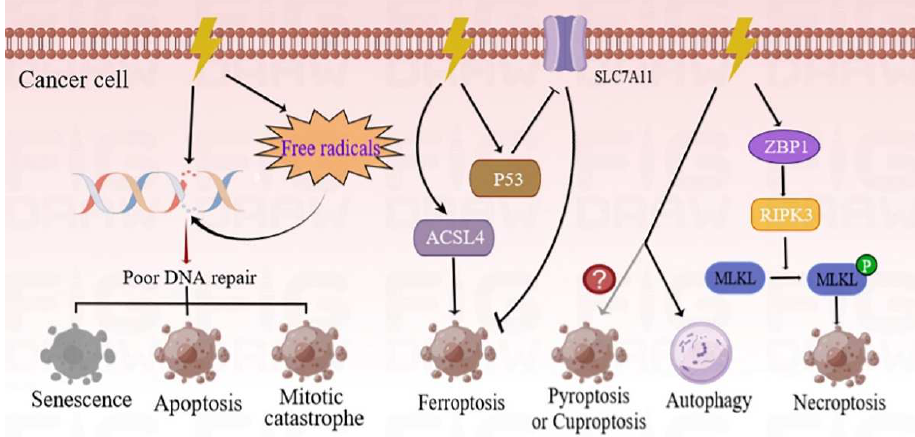
Figure 1. Different forms of cancer cell death programs induced by RT. RT can directly damage the DNA through production and deposition of ionizing energy or indirectly via free radicals. The DNA strands can be damaged in single-strand and double-strand breaks. If these DNA lesions cannot be properly repaired, tumor cells will initiate different types of death programs, including mitotic catastrophe, apoptosis, and senescence. Ionizing radiation (IR) can induce not only the expression of ACSL4 but also the activation of p53, and hence, results in elevated ferroptosis. The ZBP1-RIPK3-MLKL necroptotic cascade induces accumulation of cytoplasmic mtDNA in irradiated tumor cells, and consequently, activates an anti-tumor immune response. Conversely, autophagy is more inclined to cause cancer cell survival following IR treatment. However, there is a need